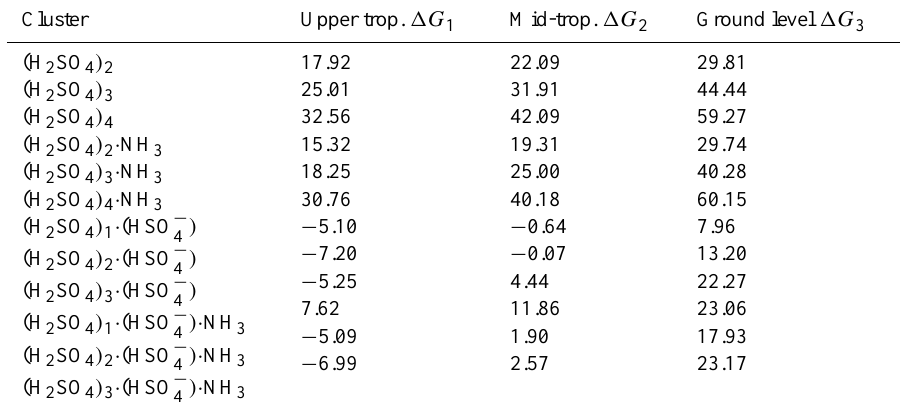
Table 4. The formation free energies for various cluster at atmospheric conditions listed in Table